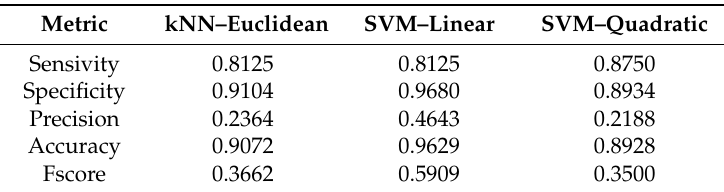
Table 5. Scenario